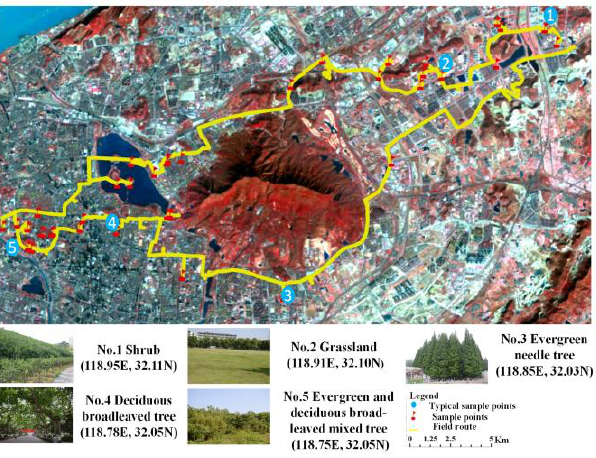
Fig. 2. The route of field survey and the sample points Combining remote sensing data and meteorological data, “HJ Quality Assurance (HJ QA) is developed analogy to the MODIS Quality Assurance (MODIS QA) which indicates the signal to noise ratio (SNR) of the original remote sensing data [12]. The values of quality level are shown in Table 1; the larger the value of quality level, the higher the signal to noise ratio (SNR) of the original HJ data. In this research, the quality level of grassland is 5 and evergreen coniferous tree is 1.